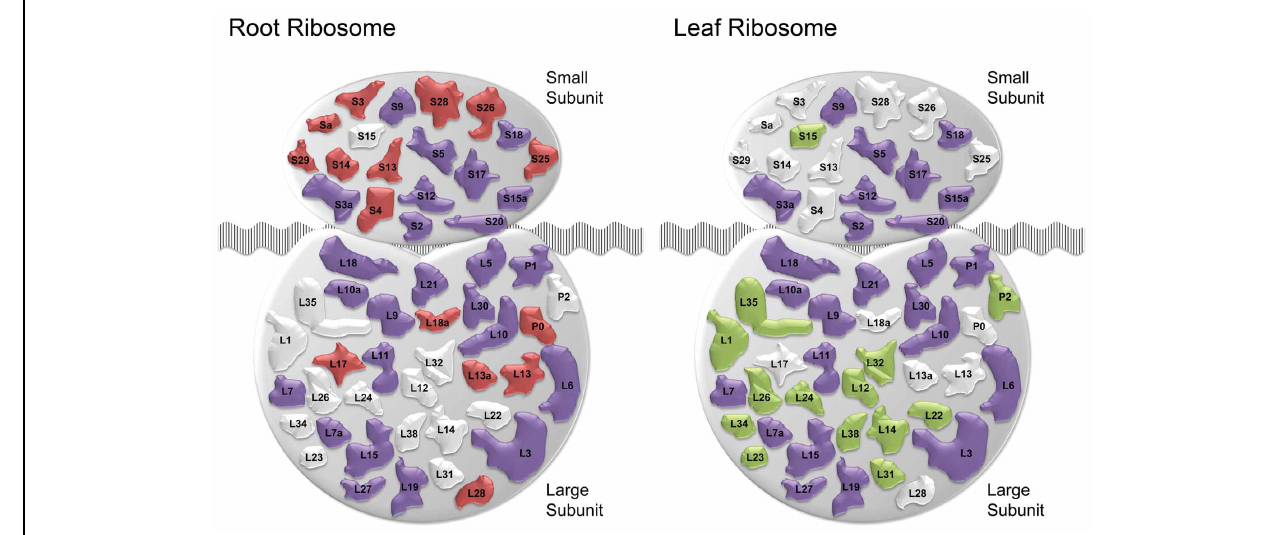
specifically in roots and leaves, respectively. Purple colored shapes represent families down-regulated in both organs. White colored shapes denote families not regulated in the corresponding tissue ribosomes.